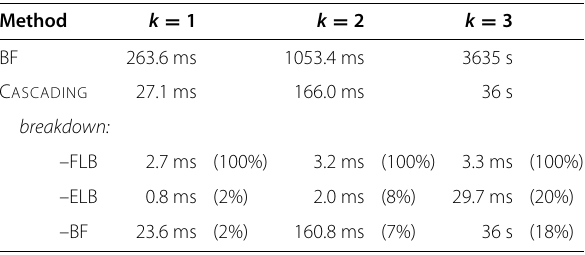
Table 9 Certification per-instance average execution time on B REAST _C ANCER Method k = 1 k = 2 k = 3 BF 263.6 ms 1053.4 ms 3635 s C ASCADING 27.1 ms 166.0 ms 36